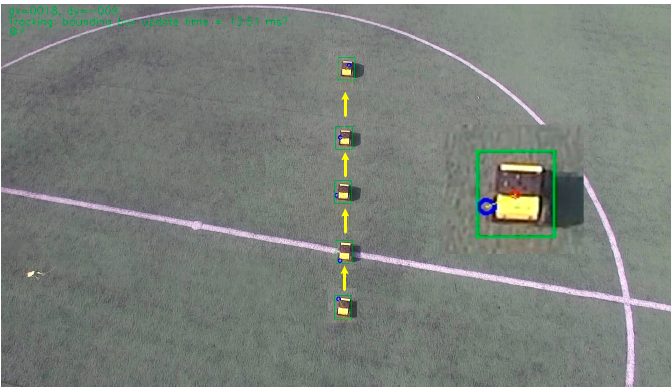
Figure 13. The experiment of tracking UGV.